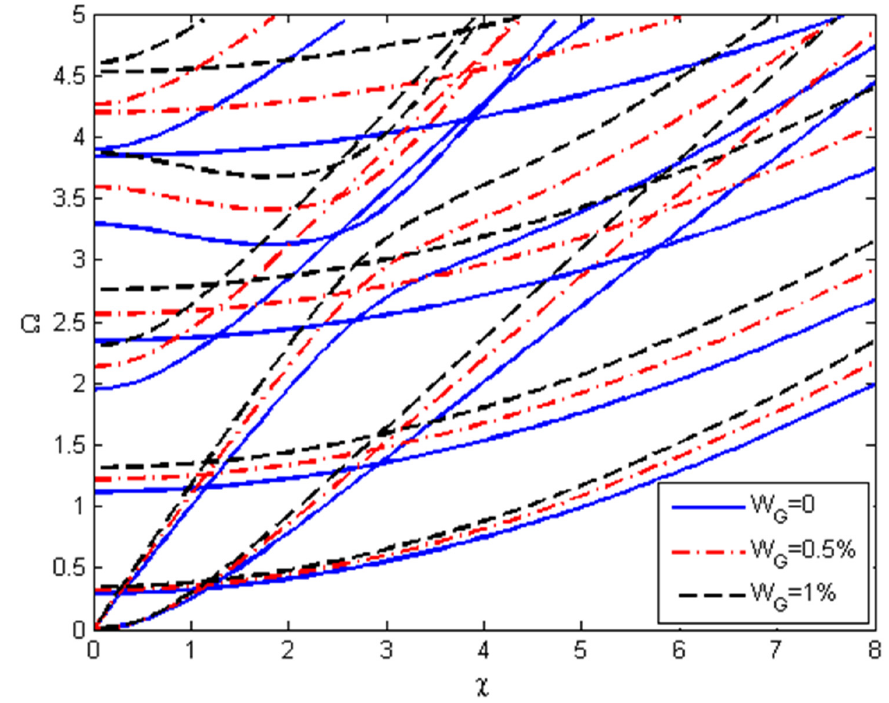
Figure 4. Effect of GPLs weight fraction WG on the dispersion spectra of GPLs reinforced plates.